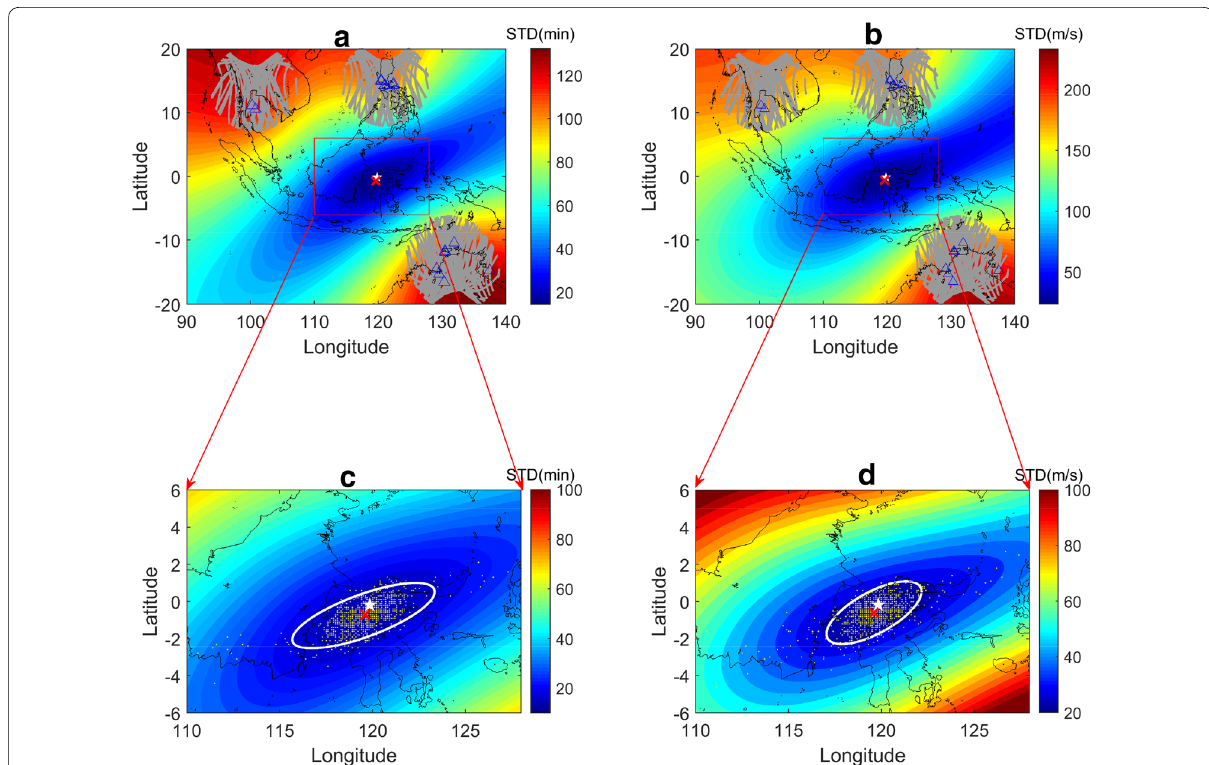
Fig. 2 Contour of STD of a travel times and b speeds estimated by the ray‑tracing and beamforming technique, separately. The blue open triangles indicate the TTID locations. The white star indicates the epicenter reported by the USGS, and red crosses represent the estimated tsunami sources. The bootstrap tsunami sources by using ray‑tracing ( c ) and beamforming ( d ). The yellow dots indicate the bootstrap locations of tsunami source. The white ellipses represent the 90% confidence interval for the possible tsunami source